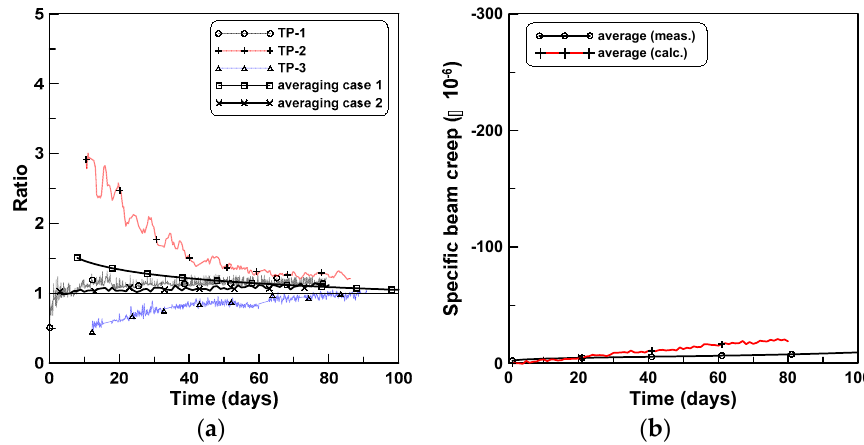
Figure 11. Bending creep strain ratio: ( a ) measured and calculated and ( b ) average of measured and calculated.